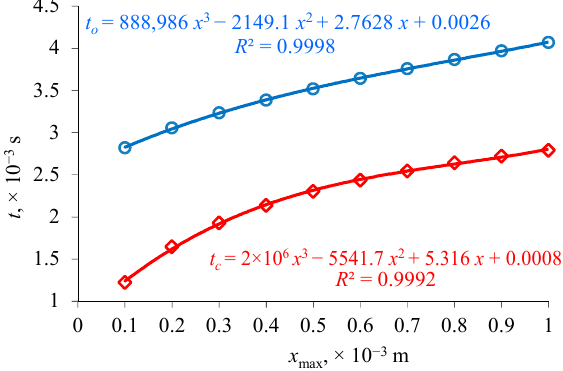
Figure 9. Relation of opening t o and closing time t c to plunger stroke x max .